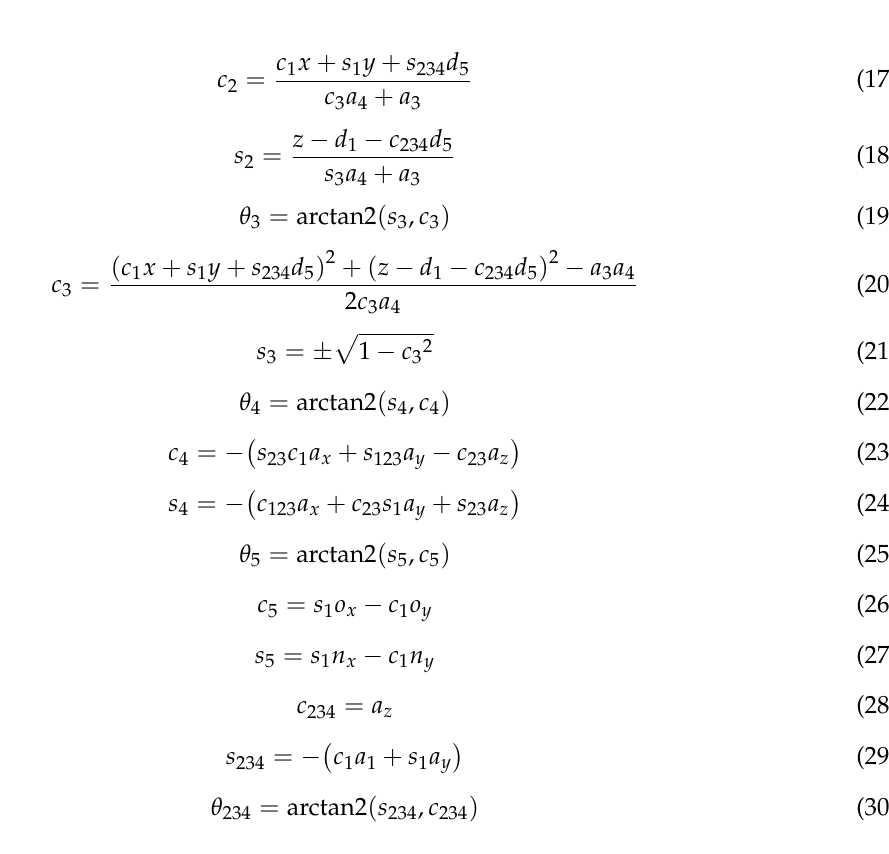
Figure 6. Theoretical and measured paths for a robot arm moving along a rectangular path without a payload. It should be noted that the actual position was determined using the position encoder of the servo motor as the robotic arm moved over time. The angles measured using the encoders were compared to the theoretical angles from the simulation calculation, where the angle of each axis was converted to the corresponding actuator coordinates using forward kinematics, as mentioned earlier. The aim was to verify that the forward kinematics and inverse kinematics were correctly presented in the study. In Figure 6, the solid red line represents the planned path from the numerical calculation by the computer program, while the solid blue circular dots stand for the measured coordinates of the robot arm end actuator in actual motion. The average errors of the tri-axial coordinates were determined as X = 2.49%, Y = 0.14%, and Z = 0.28%. Similarly, the simulated and measured results of axis angles for all the servo motors are shown in Figure 7. It can be found that the angle deviation of the third axis is more severe than that of the other axes because the third axis is influenced by the weight of the robotic arm under the load of the servo motor. The average angle errors are 11.11% for the 0-th axis, 14.39% for first axis, 4.85% for the second axis, and 4.90% for the third axis. Tests were also carried out with the gripper carrying